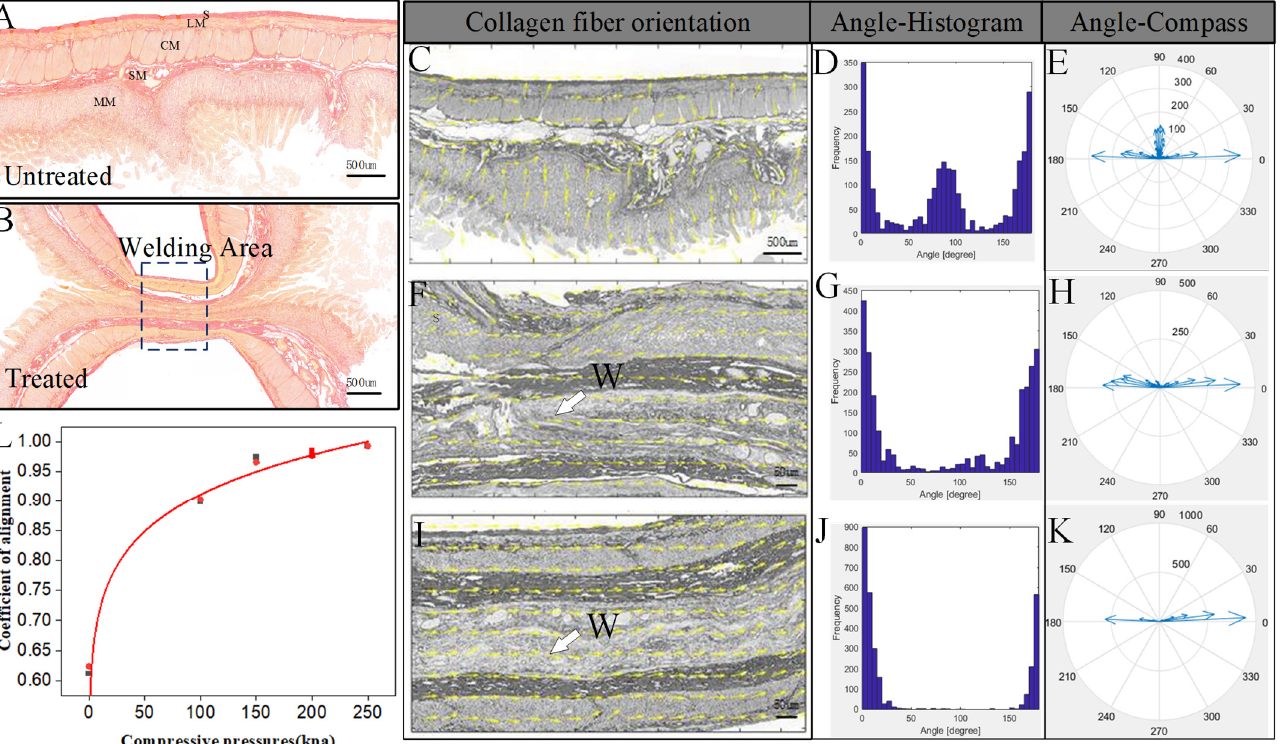
Figure 2. ( A , B ). Transverse histological slices of normal and fused small intestine stained with Sirius red. Collagen is dyed red. S, serosa; LM, longitudinal muscle; CM, circular muscle; SM, submucosa; MM, muscularis mucosa. ( C – E ). Tissue collagen fiber orientation, angle histogram, and angle compass for unfused small intestine. ( F – H ). Tissue collagen fiber orientation, angle histogram, and angle compass for the fused small intestine at 200 kPa and 250 kPa. ( I – K ). ( L ). Coefficient of alignment for different compressive pressure levels. The yellow arrow represents the orientation vector of the fiber. W, welding area .